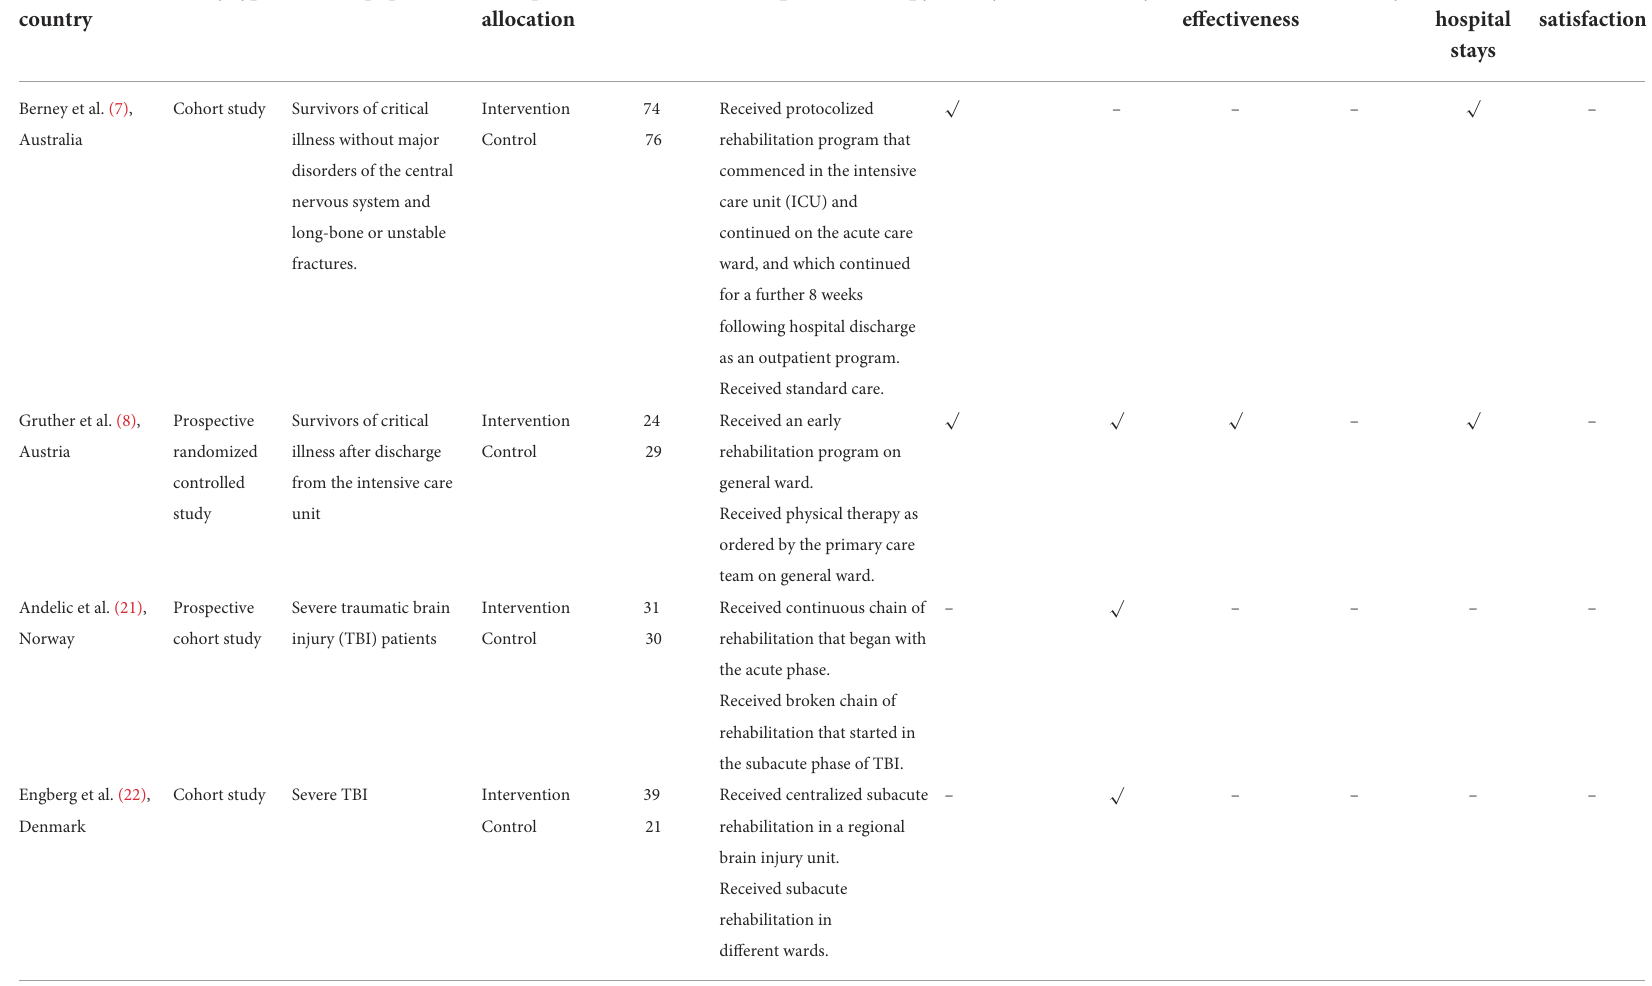
TABLE 3 Literature on a continuous chain of early rehabilitation on the acute care